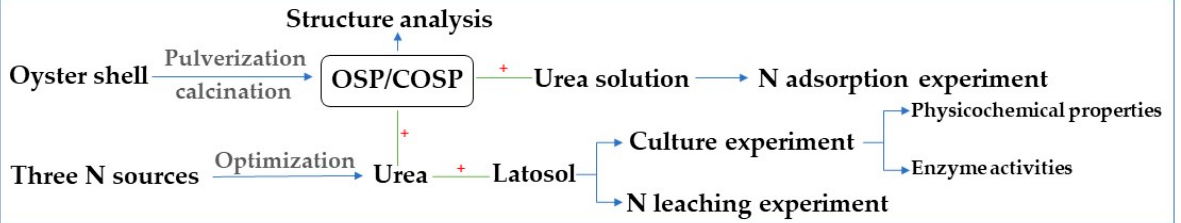
Figure 1. Flow chart graph of the experiment. “+” indicates that these experimental materials are mixed together.